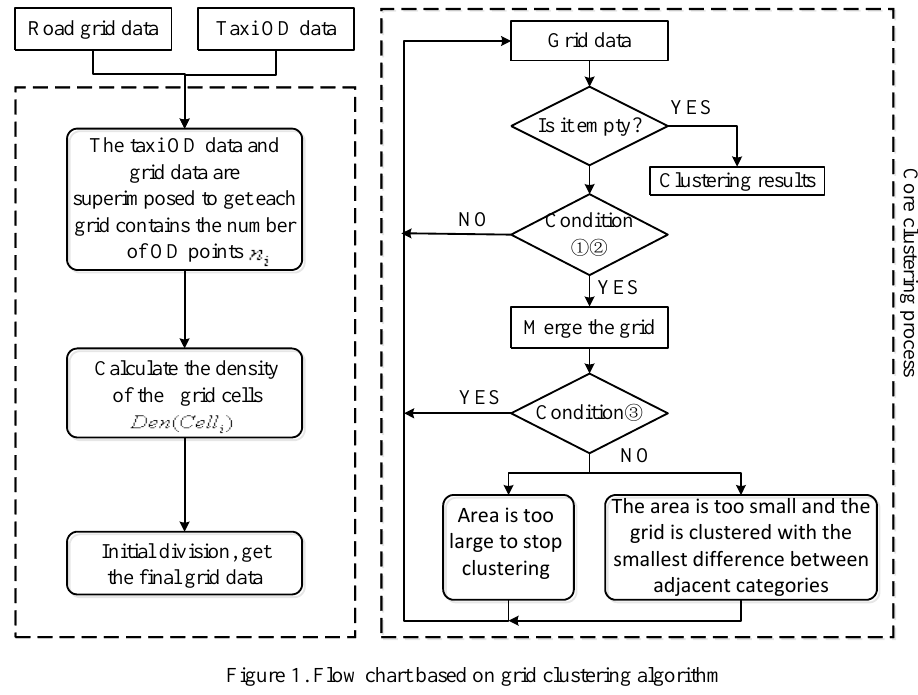
Figure 1. Flow chart based on grid clustering